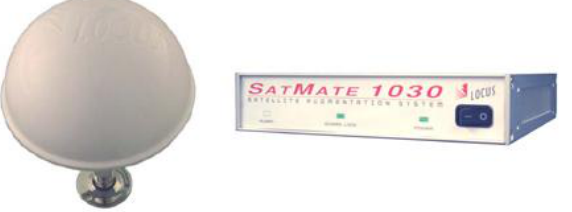
Figure 3. Loran-C H-field antenna (left); SatMate receiver